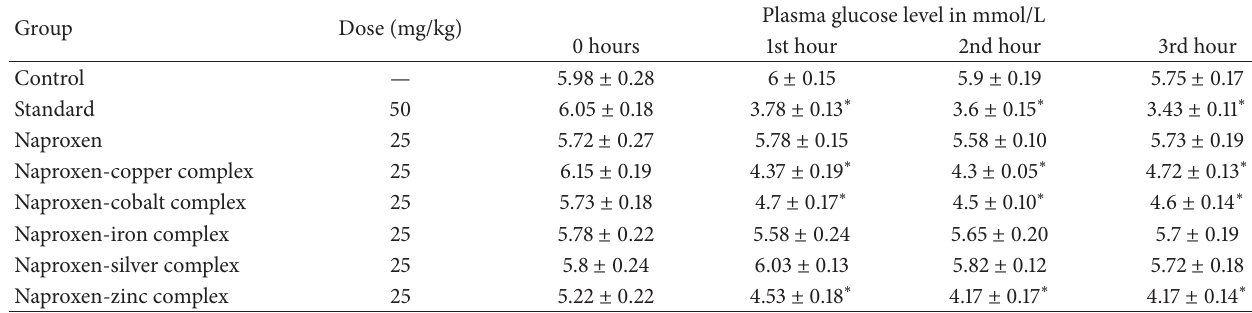
Table 5: Effect of naproxen metal complexes on hypoglycemic property in